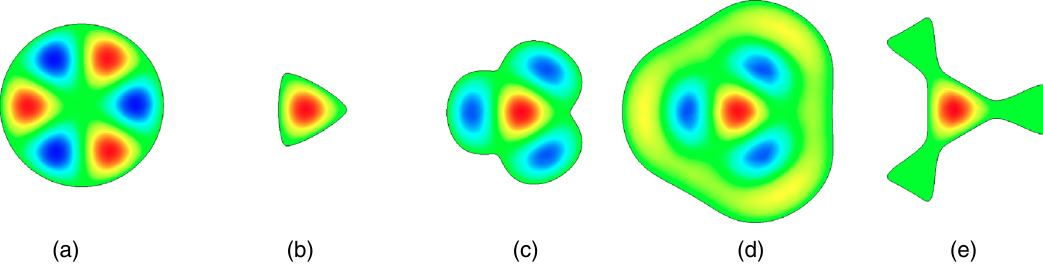
− TM and hybrid TM modes. Red is a maximum in the field, f 0 ; 3 g η 0 f 0 ; 3 g 10 f 0 ; 3 g 30 , ˜ g 3 = ˜ g 0 ¼ 0 . 95 . (e) Hybrid TM, ˜ g 3 = ˜ g 0 ¼ 1 . 2 f 0 ; 3 g 30